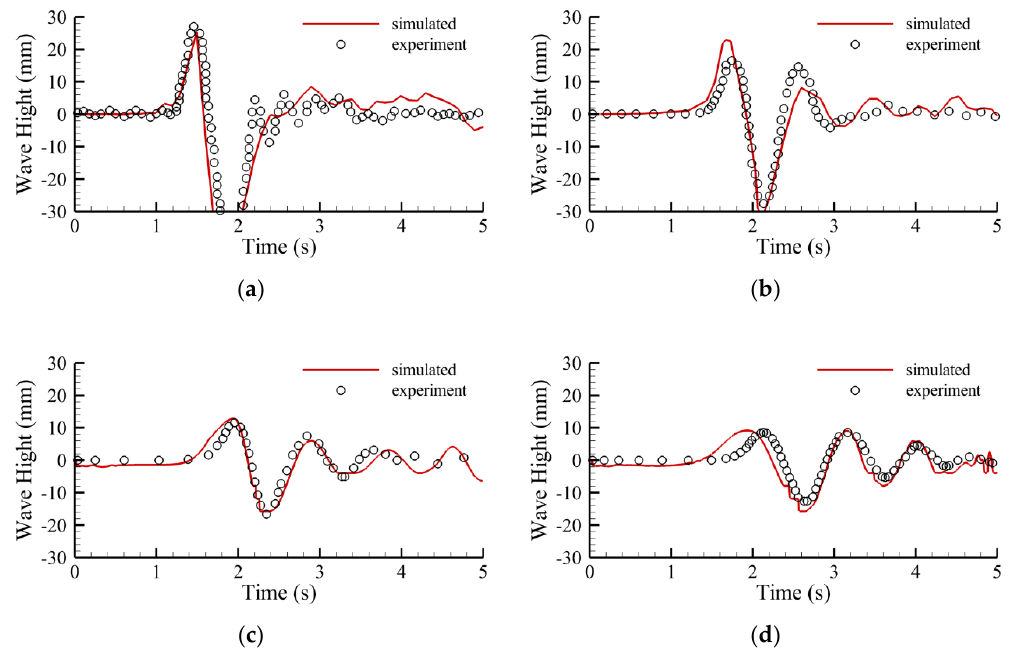
Figure 4. Validation of the temporal evolution of water elevation: ( a ) S 1 ; ( b ) S 2 ; ( c ) S 3 ; and ( d ) S 4 .